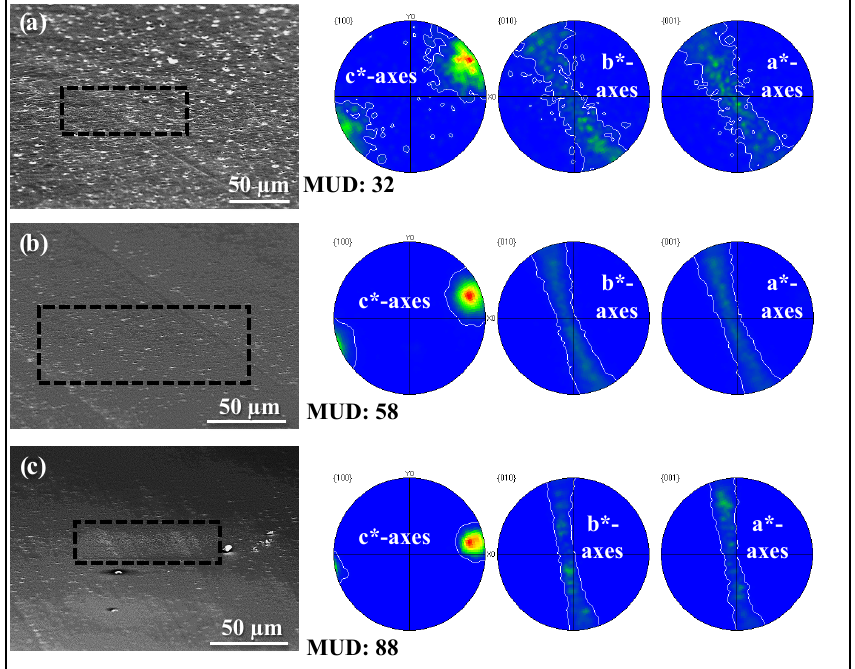
Figure A10. Pole figures obtained from EBSD measurements shown in Fig. A9. Measurements are performed on pristine Arctica islandica . SEM images on the left-hand side indicate the location of EBSD maps: (a) outer shell layer, (b) central shell portion, (c) inner shell layer. The pole figures and MUD values indicate clearly that aragonite co-orientation increases significantly towards innermost shell